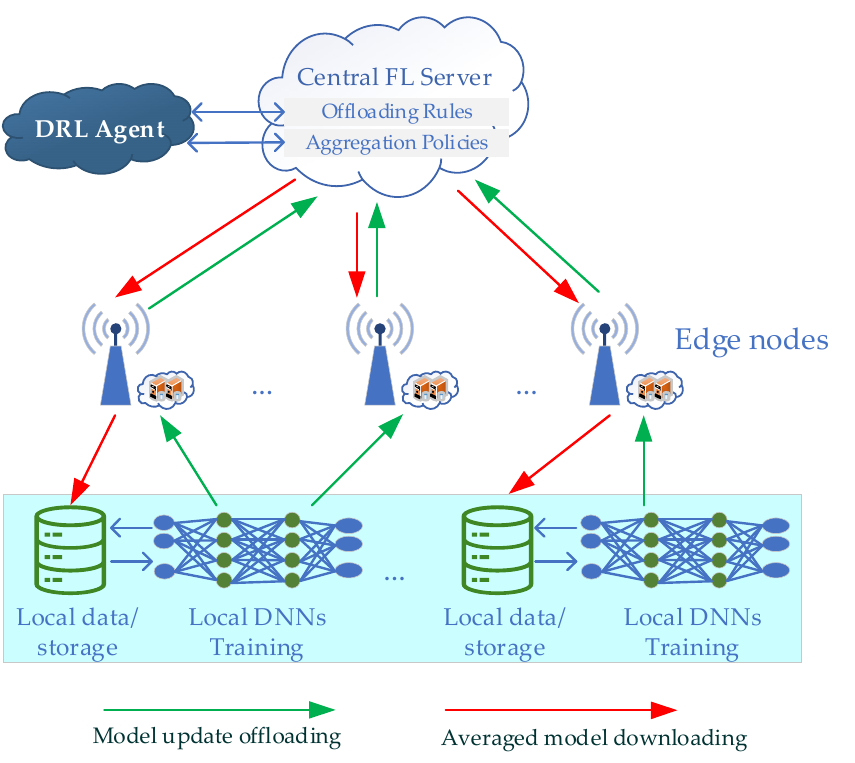
Figure 9. Embedded DRL-based optimization engine for offloading rules and aggregation policies in the central FL server.